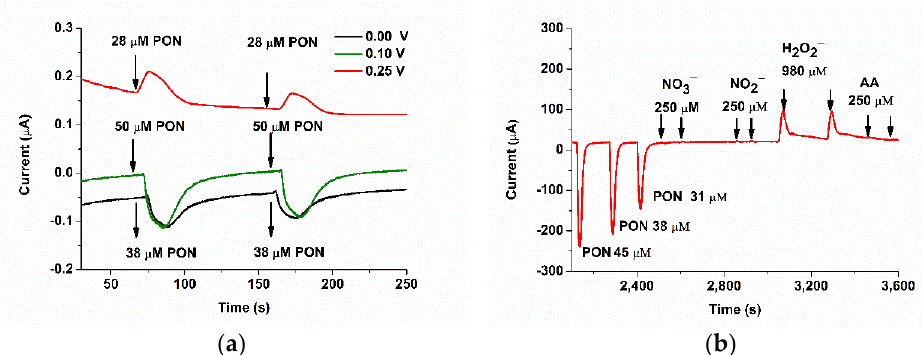
Figure 8. ( a ) Chronoamperometry (CA) spectra of the flow injection analysis (FIA) using different potentials: 0.00 V (black), 0.10 V (green), and 0.25 V (red) [1]. ( b ) Interfering species study using the FIA equipment and chronoamperometry at 0.1 V, in PBS pH 9: 250µM nitrate, 250 µM nitrite, hydrogen peroxide 980 µM and 250 µM ascorbic acid (AA), as compared to 31, 38, and 45 µM PON signals.